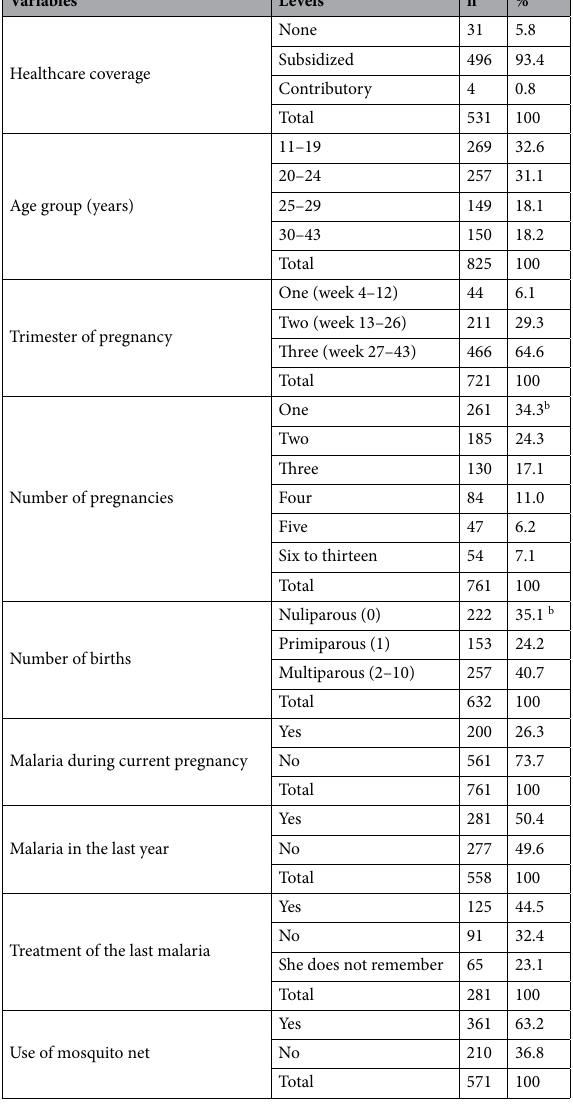
Table 1. Description of obstetric characteristics and malaria history in the study group. a The percentage was calculated based on the total number of observations registered in each variable (data lost or not registered in the medical record were excluded). b These frequencies should be the same, but the medical history does not make an exhaustive record of the number of